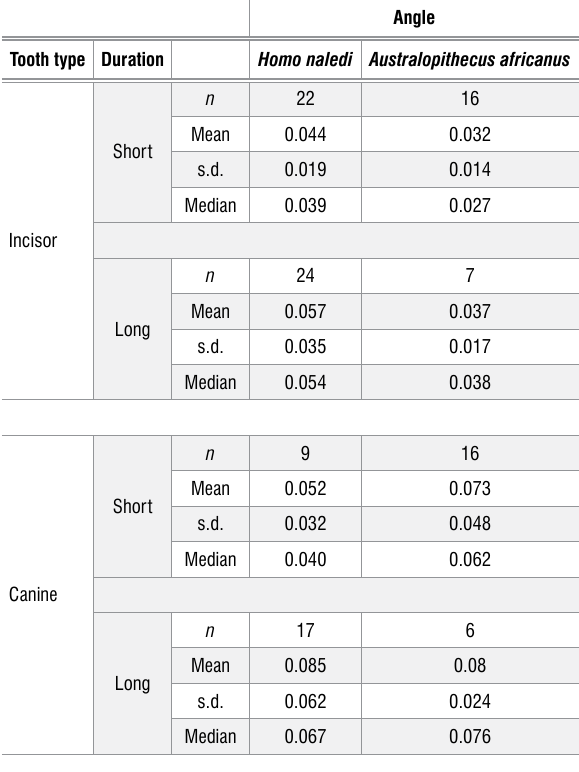
Tooth type Duration